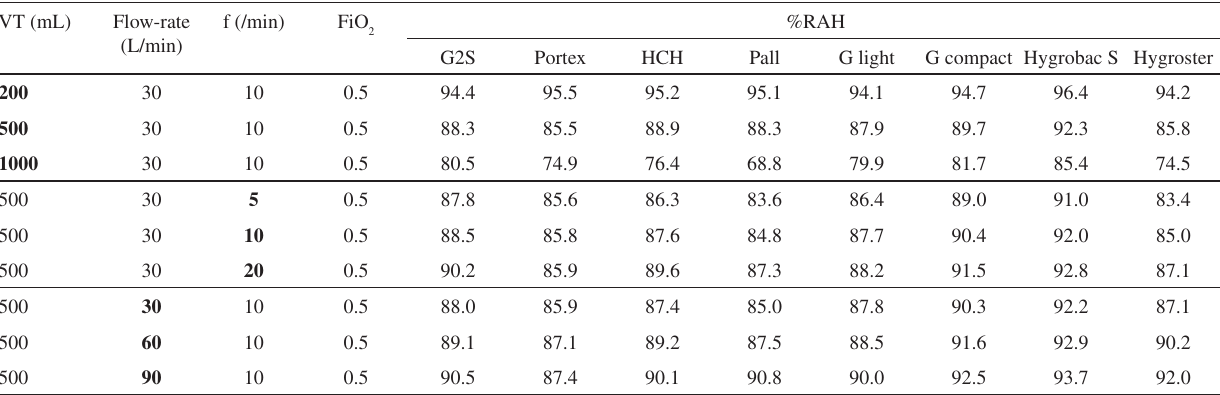
Table 1 - Ventilator settings employed and the corresponding percentage recovery of absolute humidity (%RAH) for each